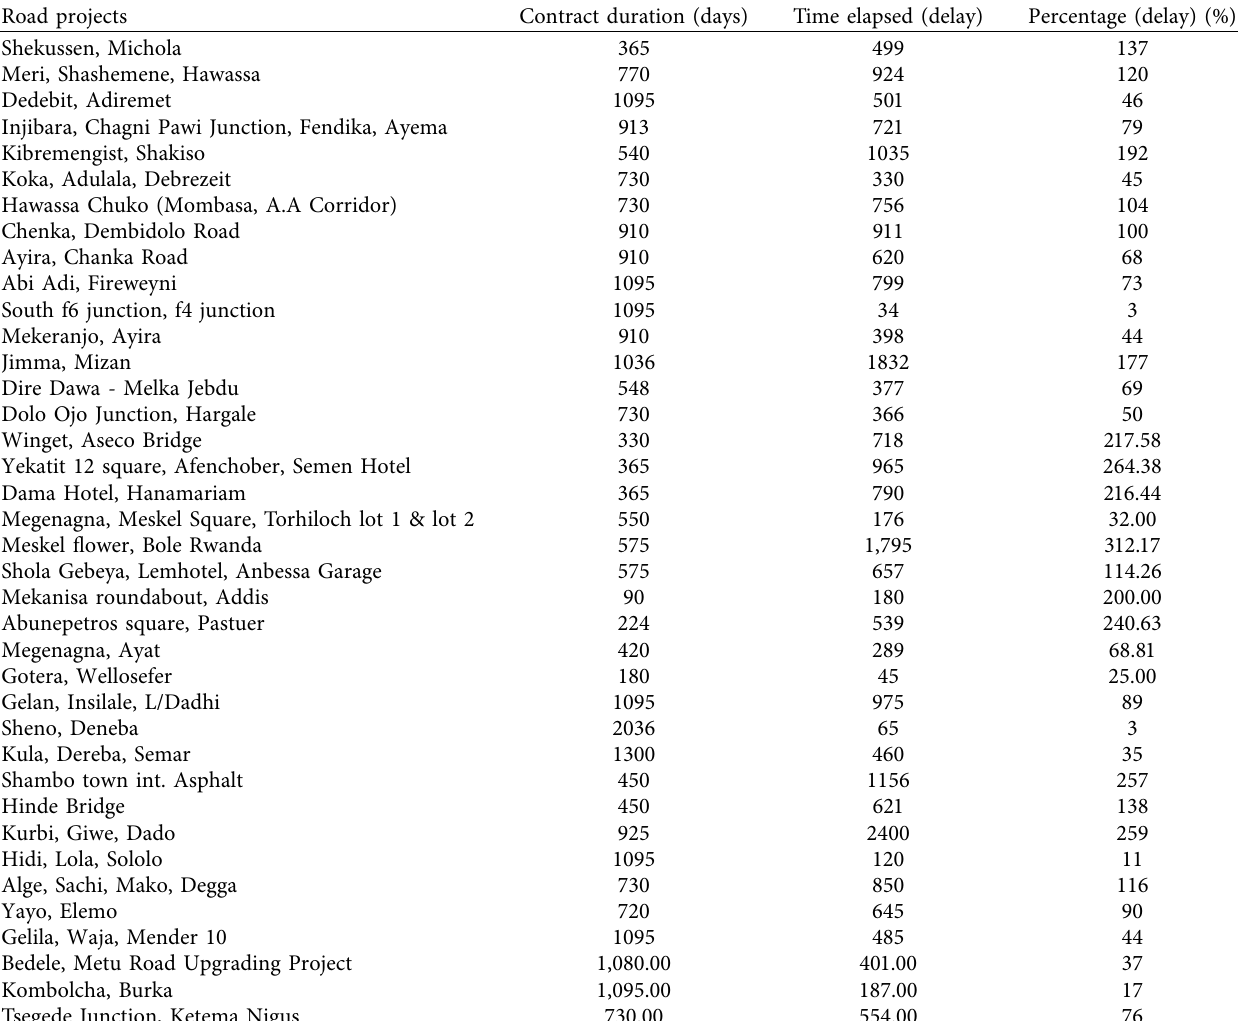
Table 6: Time data for road construction